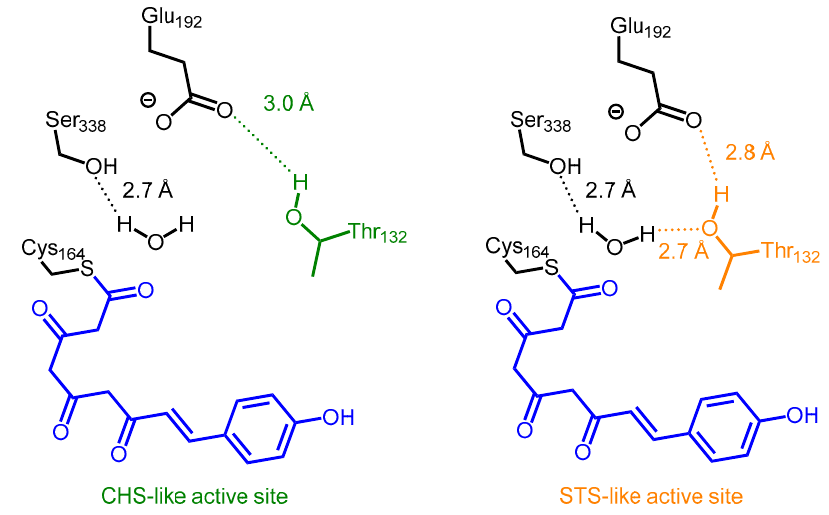
Figure 3. The hydrogen bond network involving Glu192, Thr132, Ser338, and H 2 O. Differences in this network switches the chemistry of the active site of M. sativa CHS or P. sylvestris STS between chalcone and stilbene